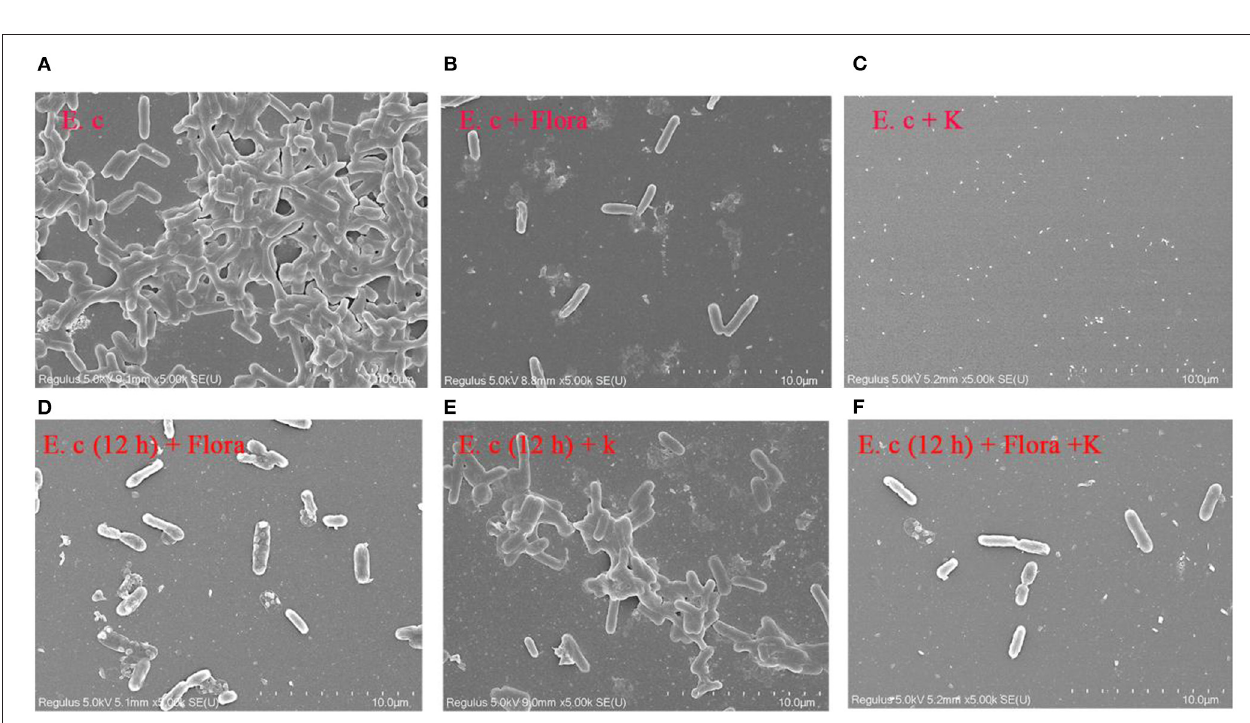
FIGURE 8 | Scanning electron micrographs (SEM) of E. coli colonization before and after phage Flora (MOI = 1) and kanamycin sulfate (10 µ g/ml) application to the biofilms formed on round coverslips. (A) E. coli was inoculated at a concentration of 4 ‰ and cultured for 24h, followed by (B) addition of phage Flora (MOI = 1) or (C) addition of kanamycin sulfate (10 µ g/ml). (D) E. coli was inoculated at a concentration of 4 ‰ and cultured for 12h, after which phage Flora (MOI = 1) was added and cultured for 12h. (E) E. coli was inoculated at a concentration of 4 ‰ and cultured for 12h, after which kanamycin sulfate (10 µ g/ml) was added and cultured for 12h. (F) E. coli was inoculated at a concentration of 4 ‰ and cultured for 12h, after which phage Flora (MOI = 1) and kanamycin sulfate (10 µ g/ml) was added and cultured for 12h (5, 000 ×